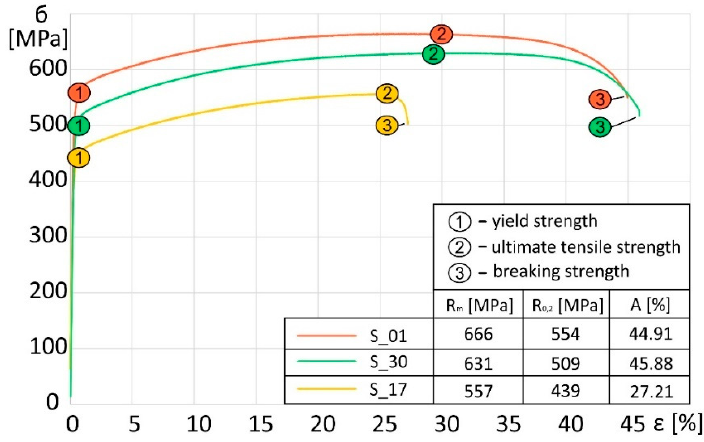
Figure 12. Monotonic stretching curves for S_1, S_17, and S_30 samples.